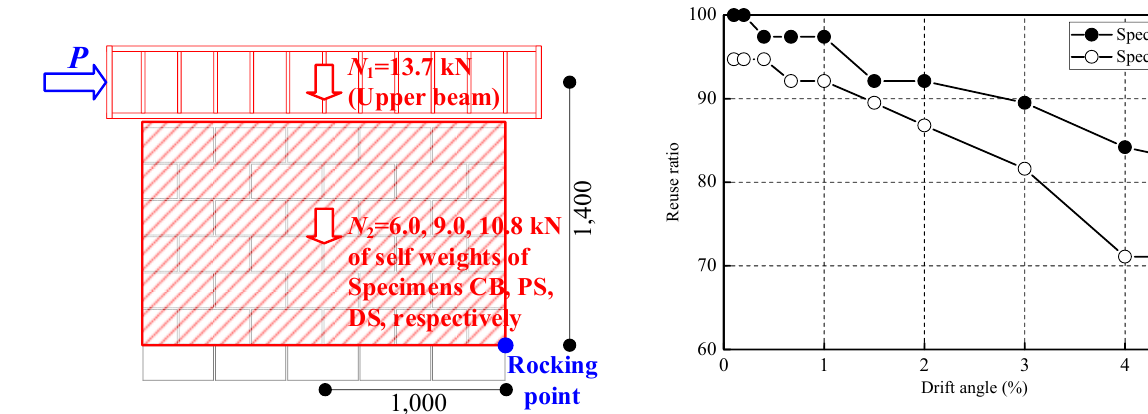
Figure 13. Reuse ratios of the main blocks of Spec- imens PS and